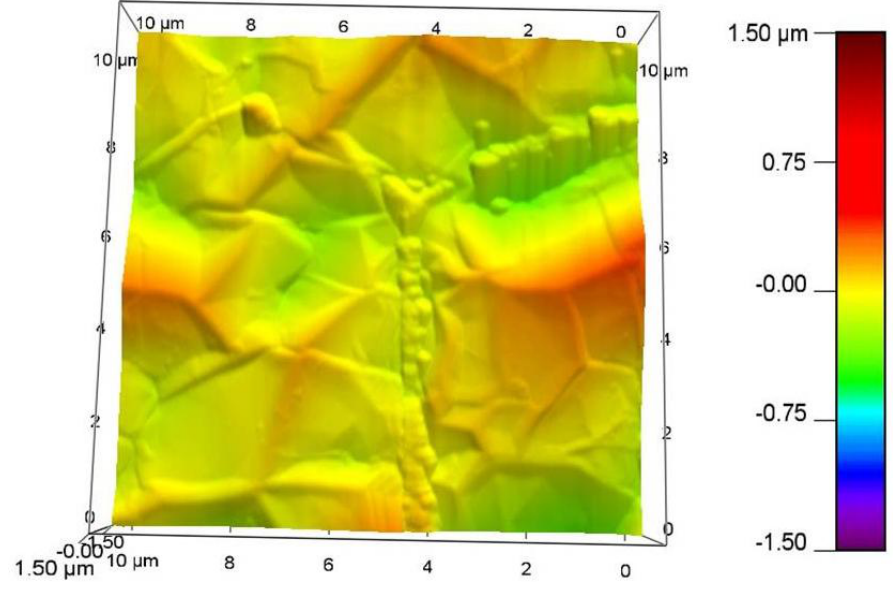
Figure A2. Atomic Force Microscopic image of CVD-grown